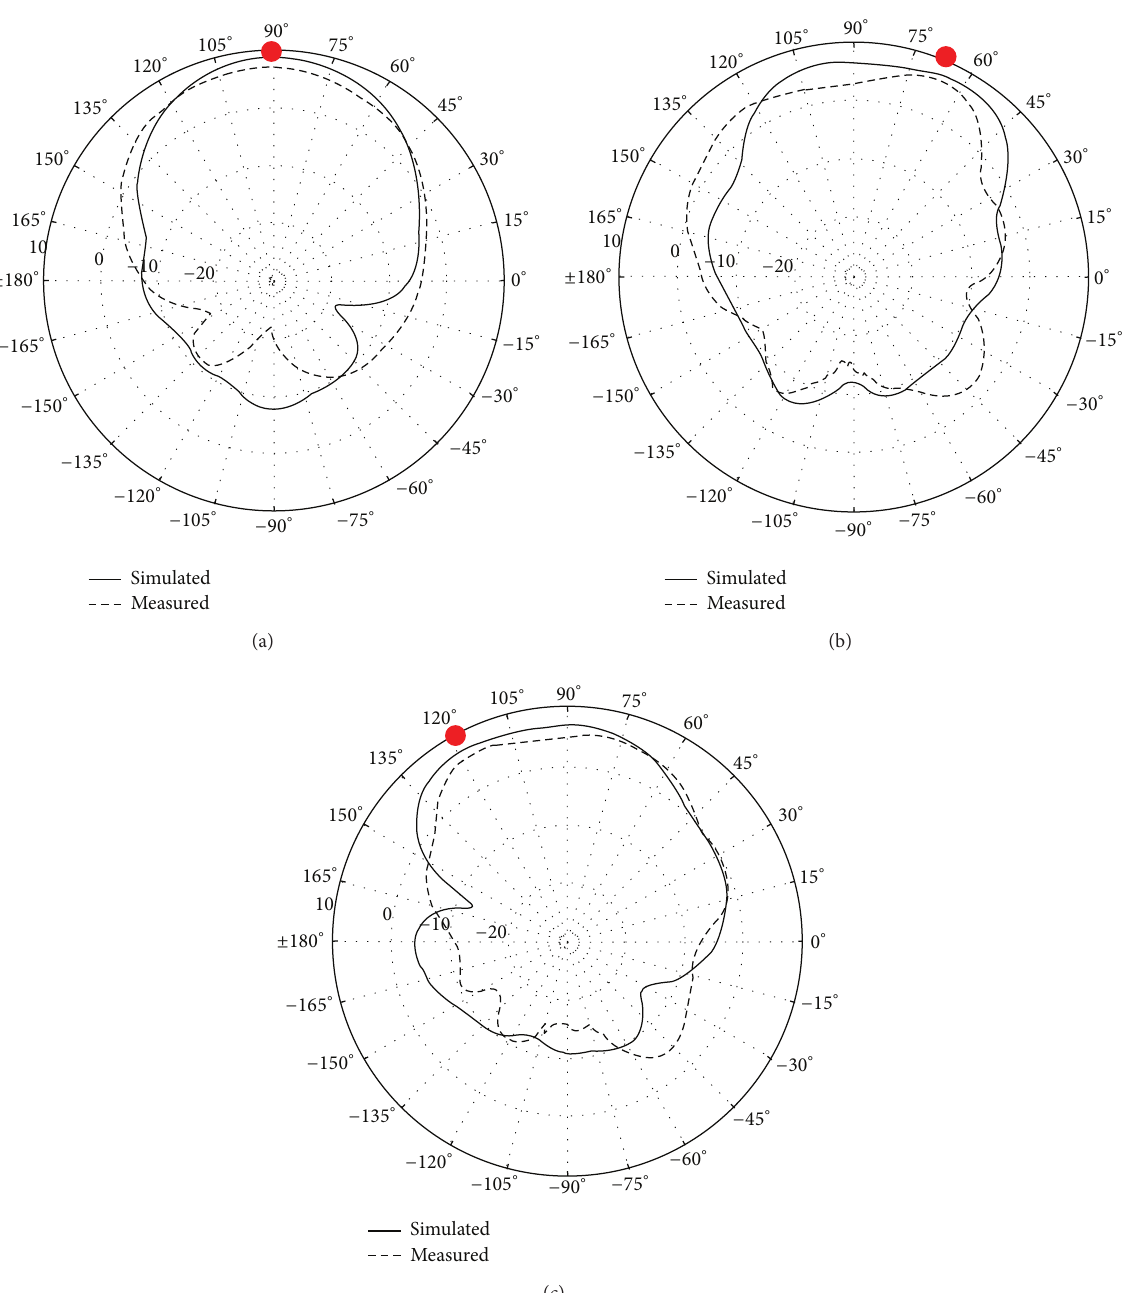
= 0.19 T and 𝐻 = 0 01 02